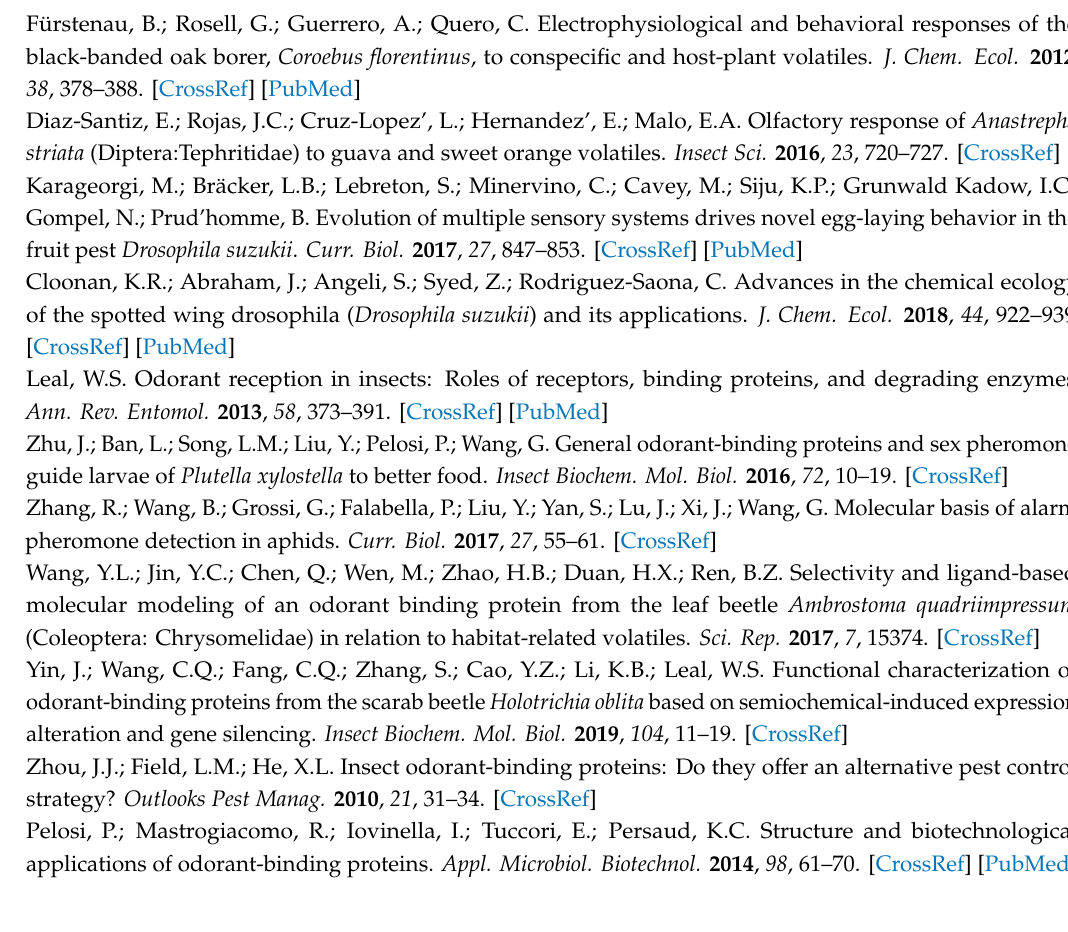
Figure S1: Nucleotide and deduced amino acid sequences of SmosOBP12 and SmosOBP17 in Sitodiplosis mosellana. Start and stop codons are boxed. Predicated signal peptides are underlined. The six conserved cysteines are